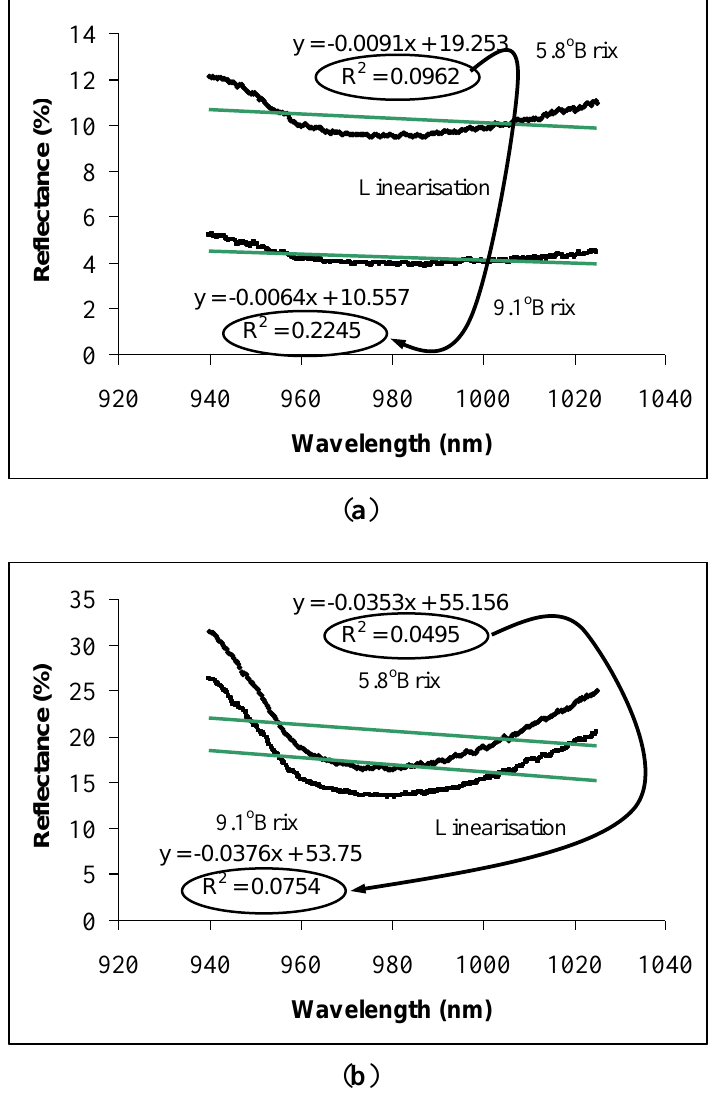
Figure 4. Spectra for two different levels of carambola SSC measured